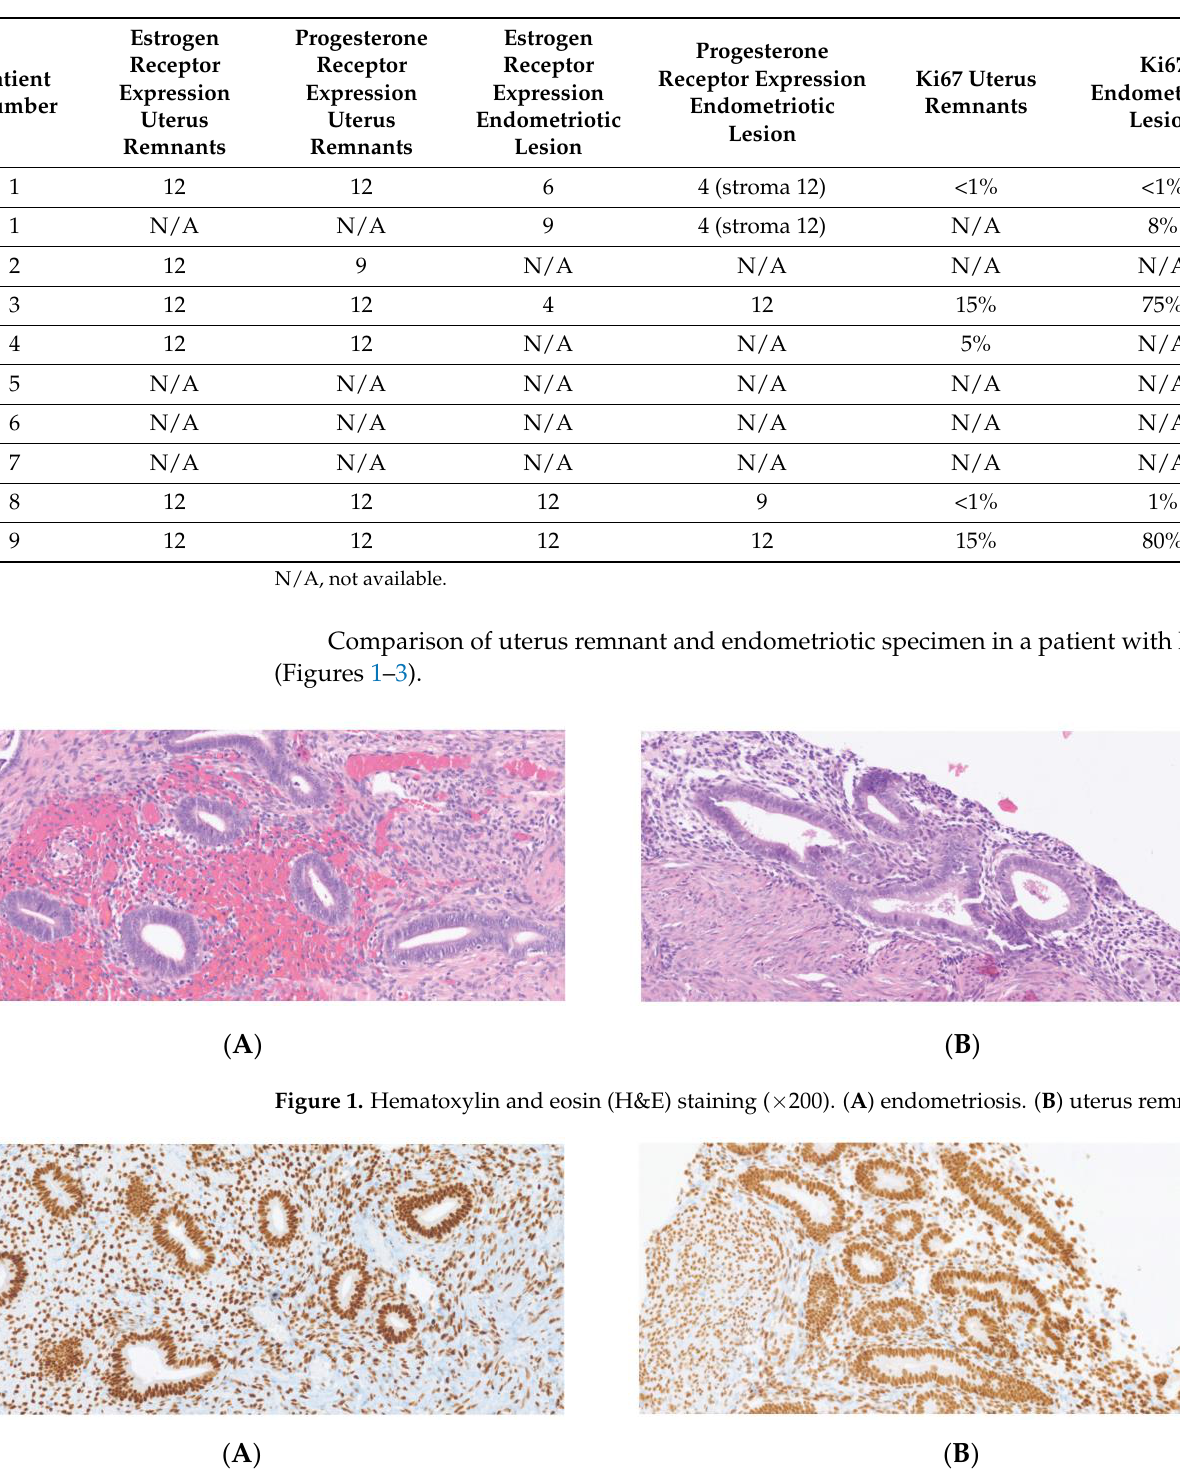
Table 2. Results for immunohistochemistry IRS (ER, PR) and Ki67.